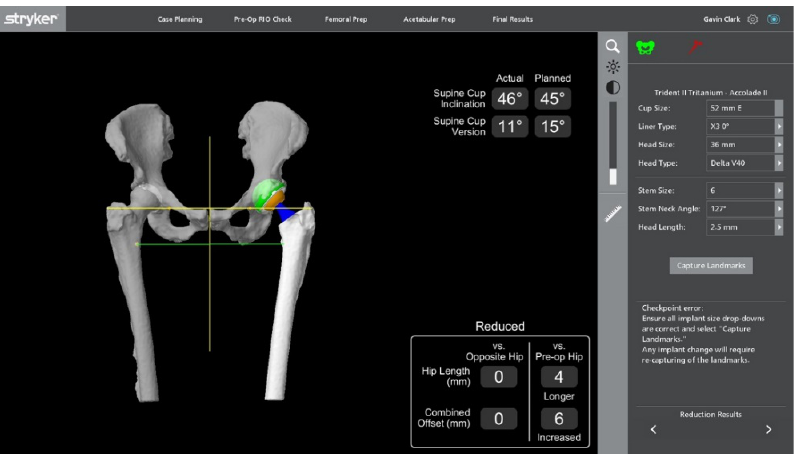
Figure 13. Post-reduction assessment detailing comparable leg lengths and offset to contralateral side. The yellow lines cross bilateral greater trochanters, and the green lines cross bilateral lesser trochanters, showing equivocal leg lengths.